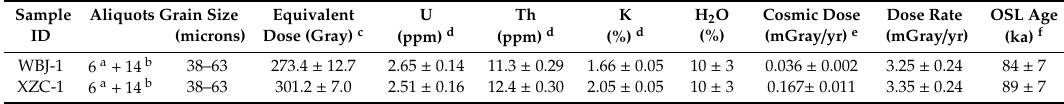
Sample Aliquots Grain